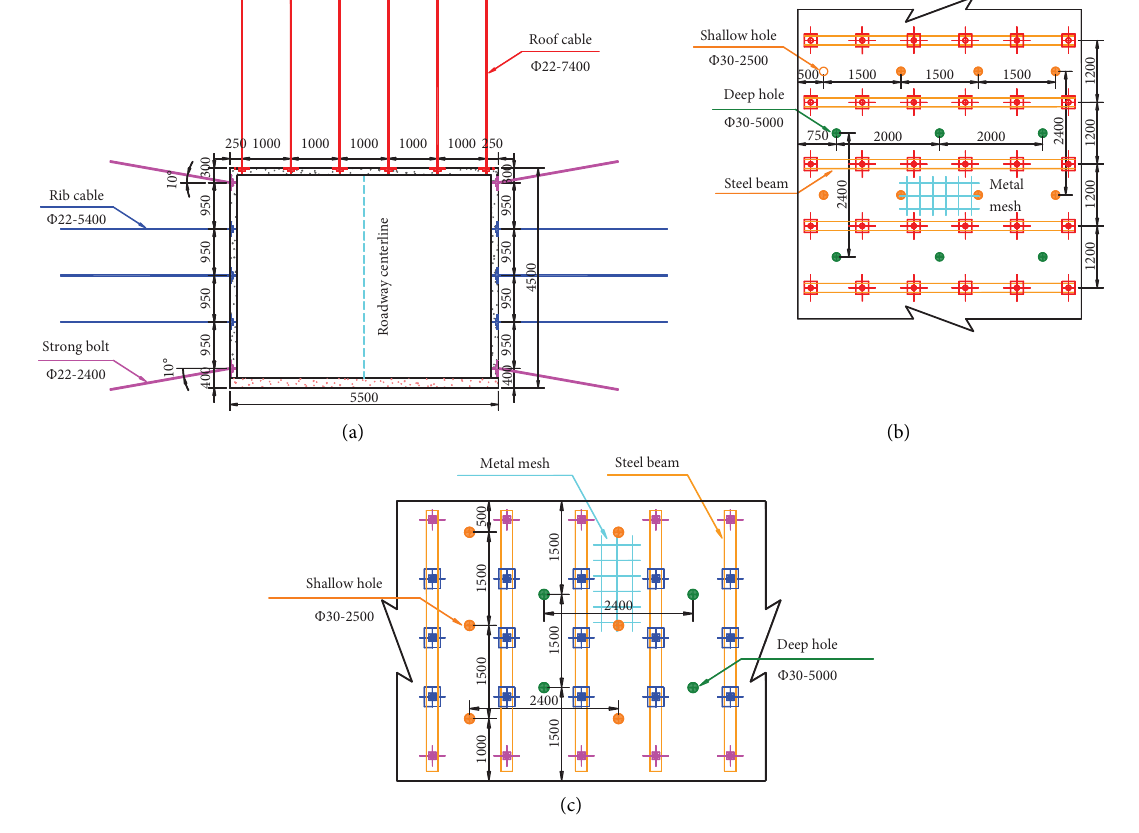
Figure 13: Roadway support parameters: (a) full section; (b) roof; (c)